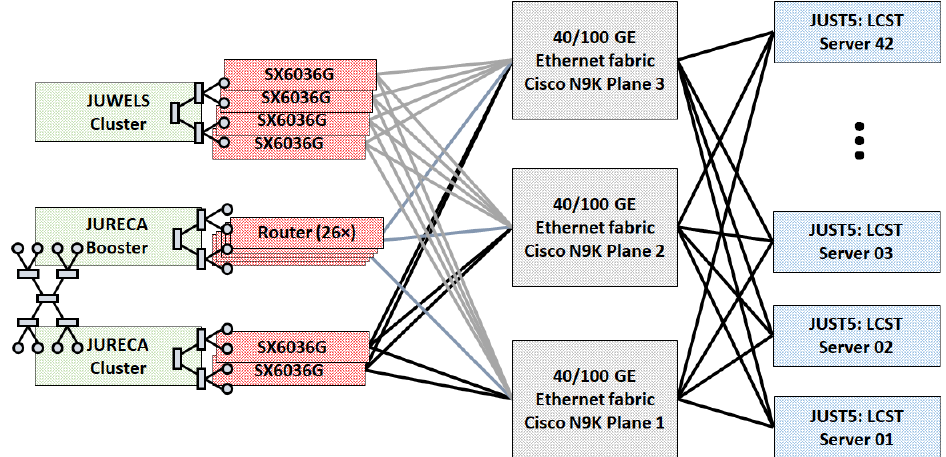
Figure 3: Schematic of the facility Ethernet fabric with a focus on the connection between supercomput- ing clients and the JUST large-capacity HPC storage tier (LCST). Please note that the sketch is rotated by 90 ◦ for the sake of presentation, i.e., the north-south traffic corresponds to a horizontal data